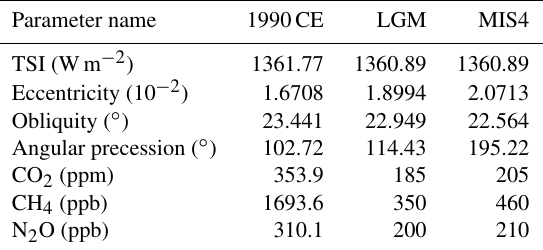
Table 1. External forcing used in this study for 1990CE, LGM and MIS4 conditions. The orbital parameters are calculated accord- ing to Berger (1978). Estimates for glacial levels of CO 2 , CH 4 and N 2 O are obtained for LGM from the PMIP protocol (https: //pmip2.lsce.ipsl.fr/, last access: 23 June 2022) and for MIS4 from ice cores according to Schilt et al. (2010) and Bereiter et al. (2014). Note that the external forcing corresponds to the values of the driv- ing the CCSM4 simulations (Hofer et al., 2012a,